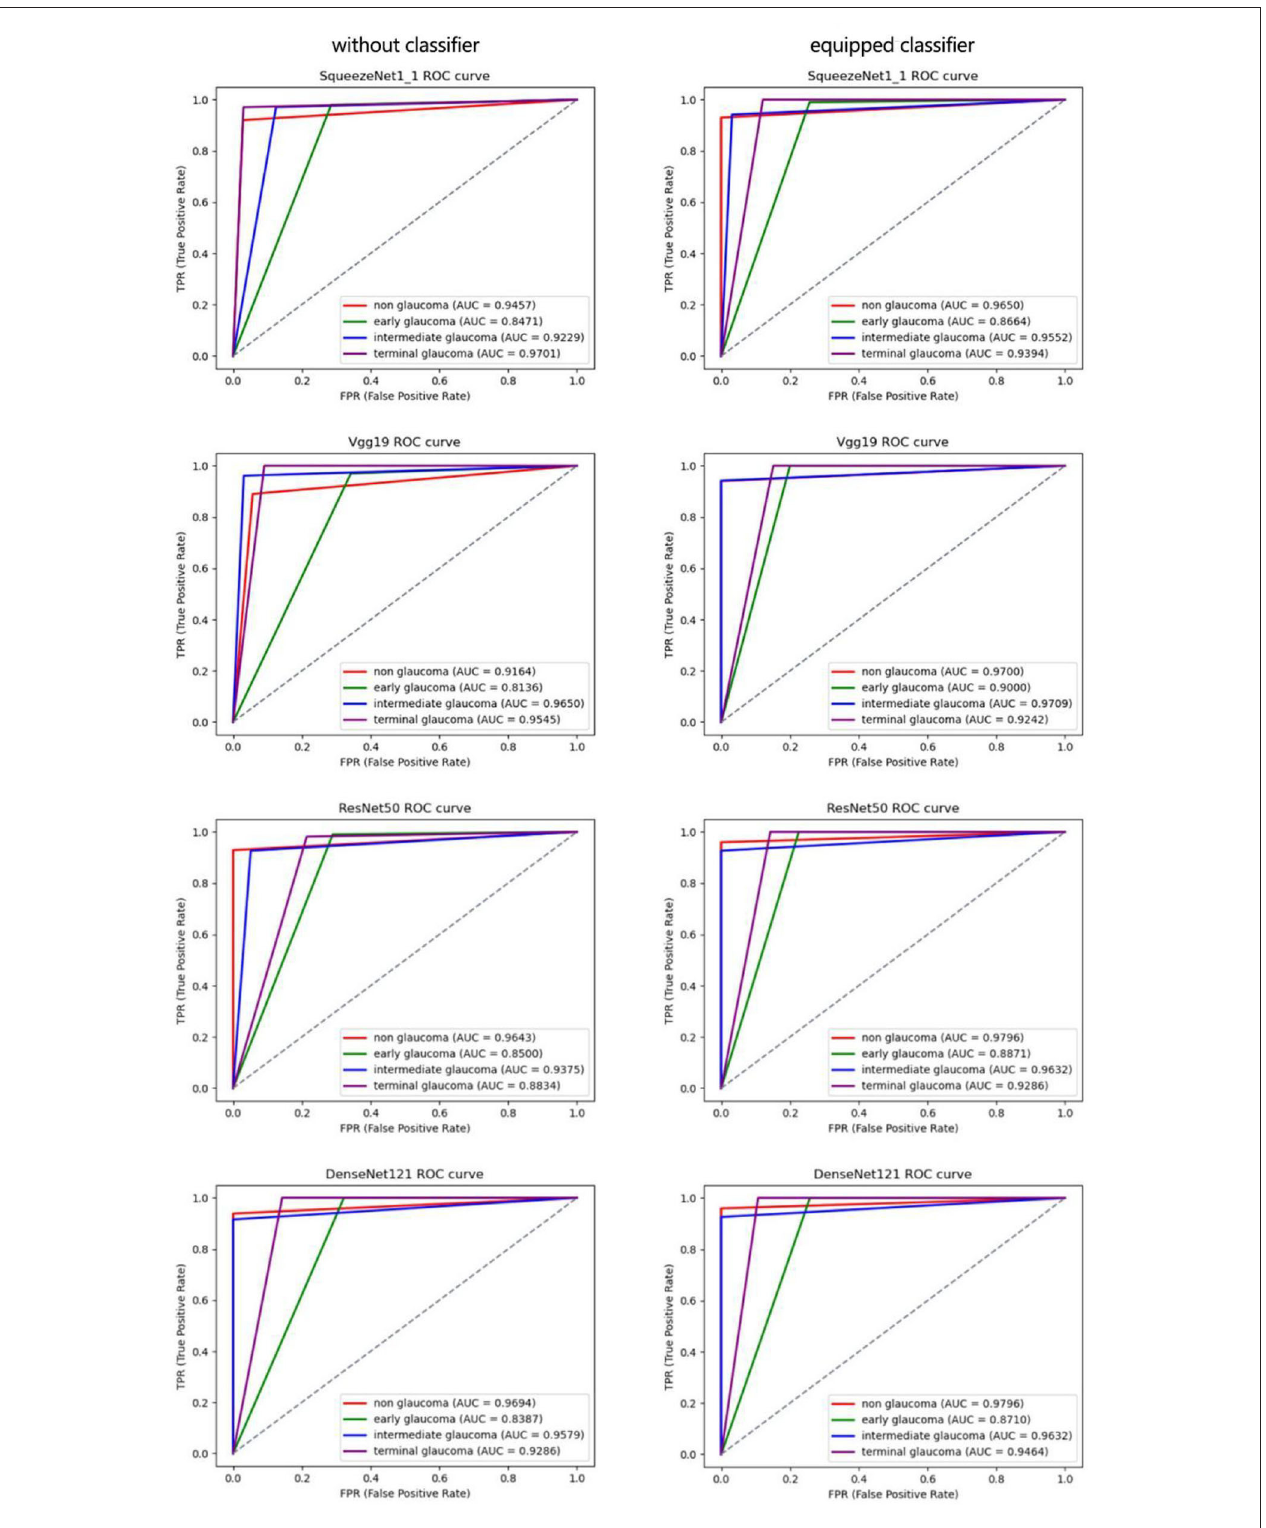
FIGURE 8 | Receiver operating characteristic curves of each subcategory for 4-category classification deep CNN.